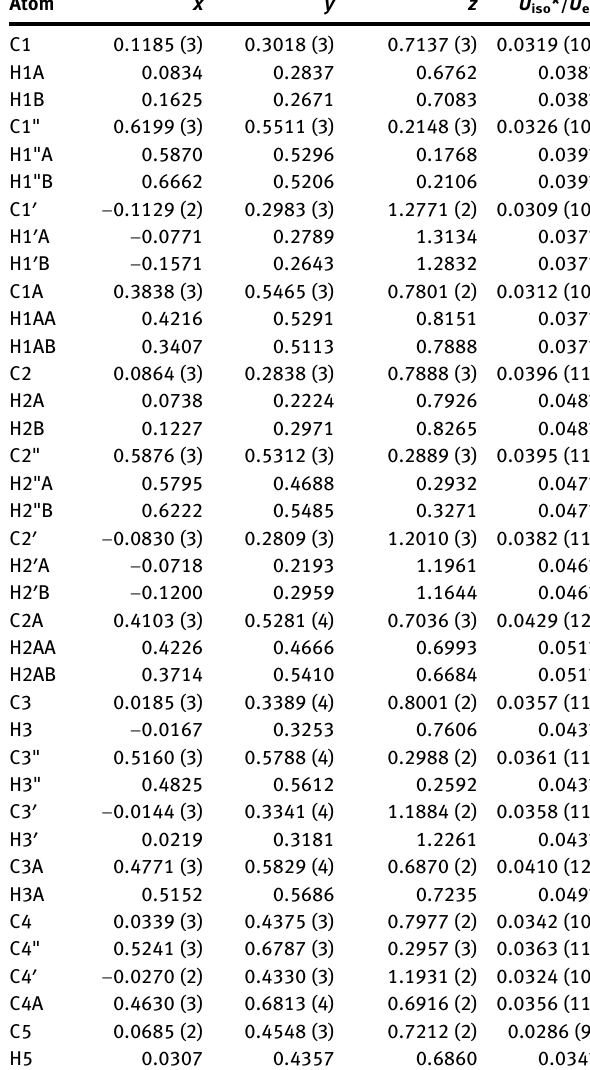
Table  : Data collection and handling. Crystal: Colourless